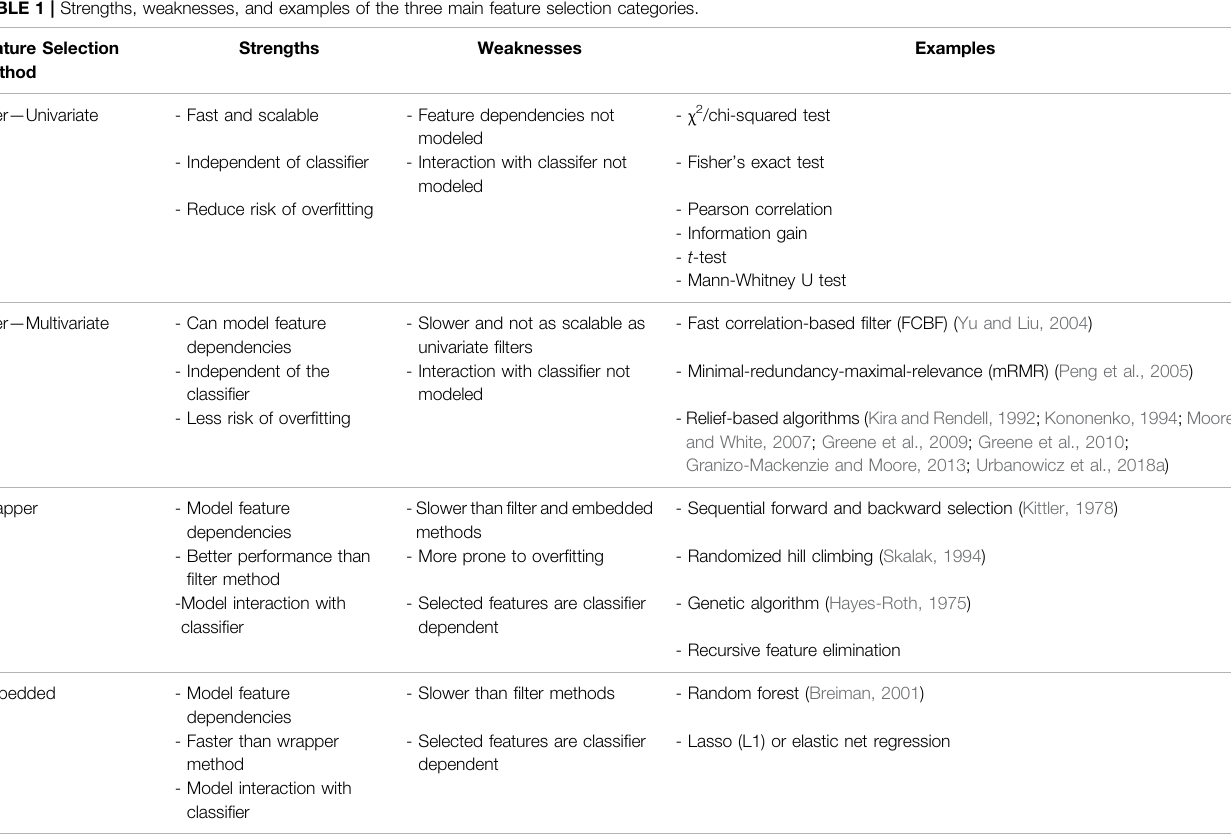
TABLE 1 | Strengths, weaknesses, and examples of the three main feature selection